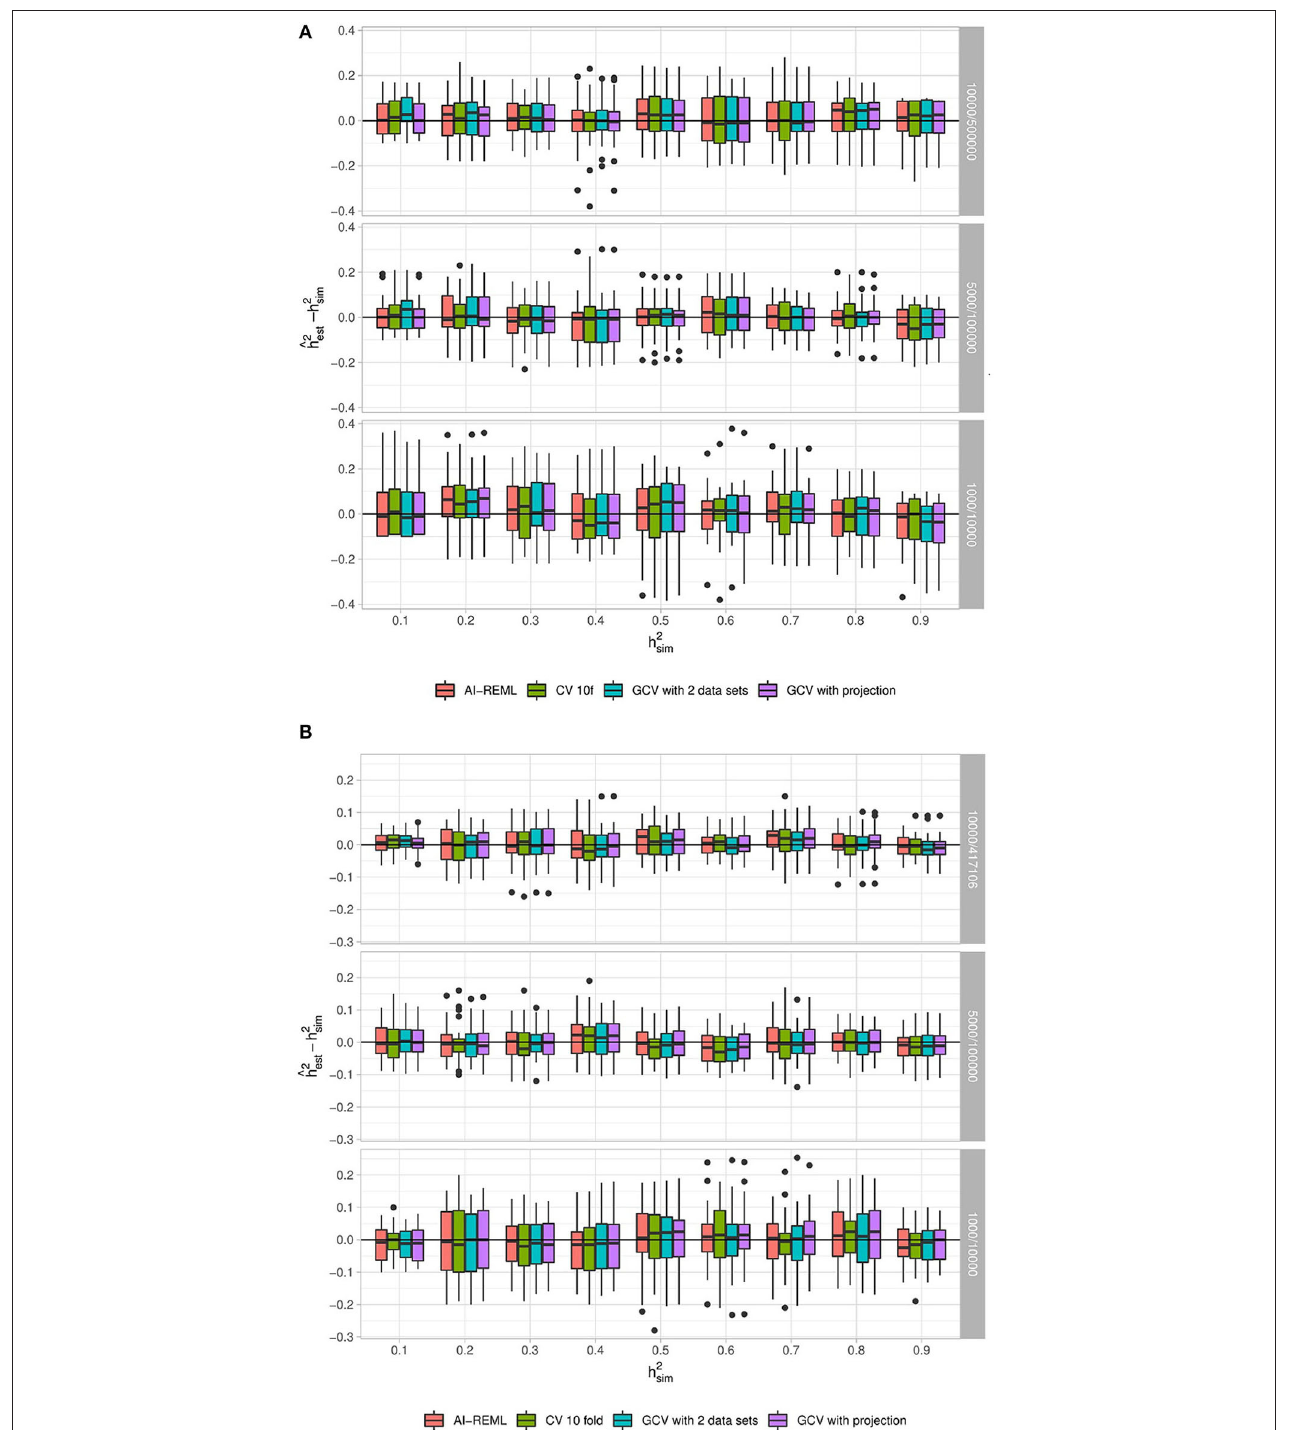
FIGURE 4 | Distribution of ( h 2 est − h 2 sim ) for different parameter combinations with 30 replications. (A) Corresponds to data simulated under the “fully synthetic” procedure, while (B) corresponds to the “semi-synthetic simulation” procedure. Each sub-panel corresponds to a different value of n / p . In both scenarios 10 % of the variants have causal effects (i.e., f c = 0.1). For each panel, the horizontal axis corresponds to the simulated heritability h 2 sim ∈ { 0.1,...,0.9 } and the vertical axis corresponds to ( h 2 est − h 2 sim ). Heritability estimations are done with the random effects model using AI-REML and with ridge regression using three approaches for the choice of λ : GCV with a projection correction, GCV with a two-dataset correction and a 10-fold cross-validation (CV 10f).